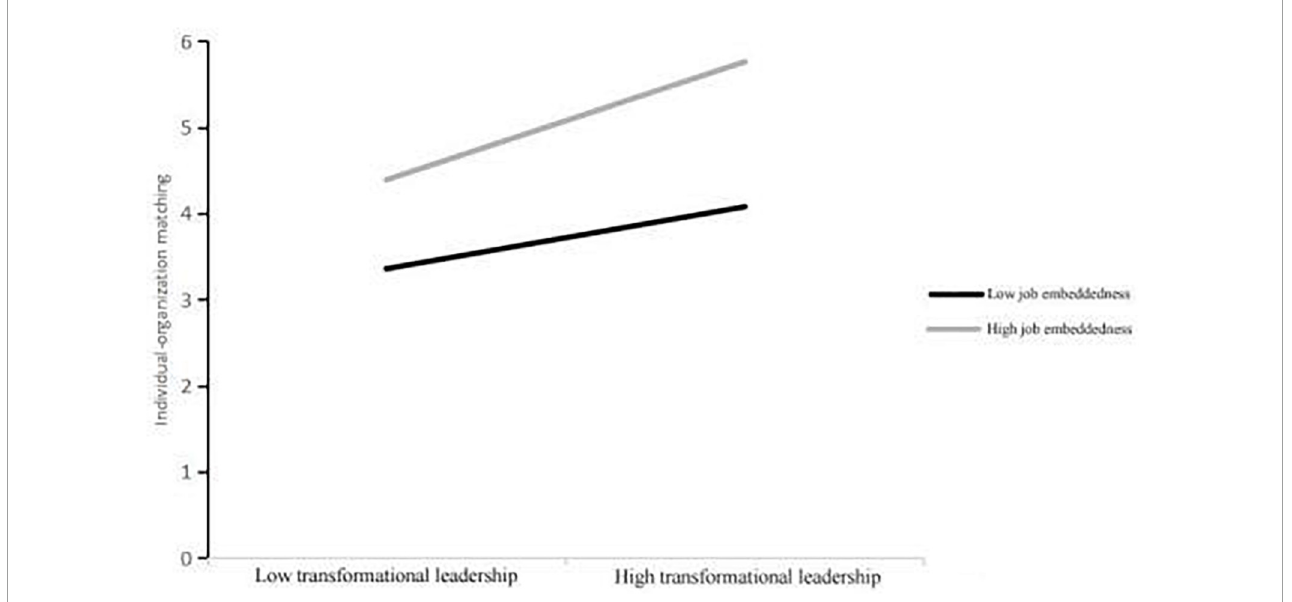
FIGURE2 The moderating effect of job embedding on the relationship between transformational leadership and person–organization